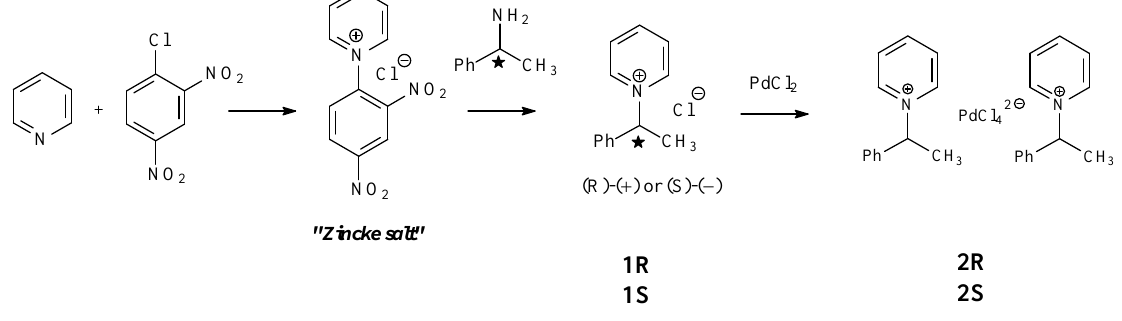
Figure 1. Synthesis of chiral pyridinium ILs and of the corresponding